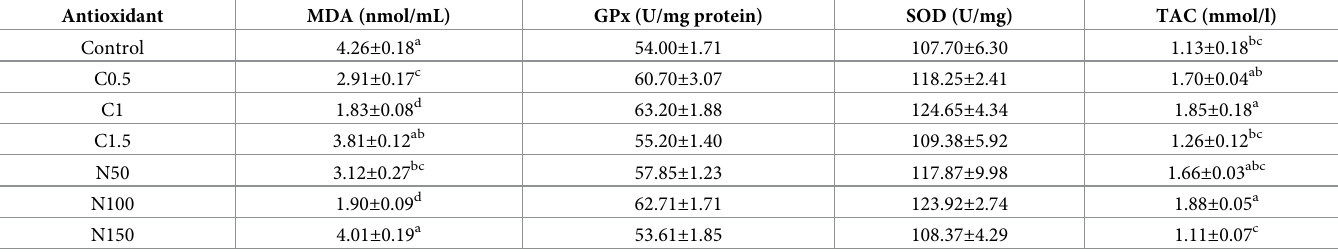
Different superscripts within the same column indicate significant differences among groups (P < 0.05). Beltsville extender without antioxidant (control), C0.5 (Beltsville extender with 0.5 mM crocin), C1 (Beltsville extender with 1 mM crocin), C1.5 (Beltsville extender with 1.5 mM crocin), N50 (Beltsville extender with 50 μ M naringenin), N100 (Beltsville extender with 100 μ M naringenin), N150 (Beltsville extender with 150 μ M